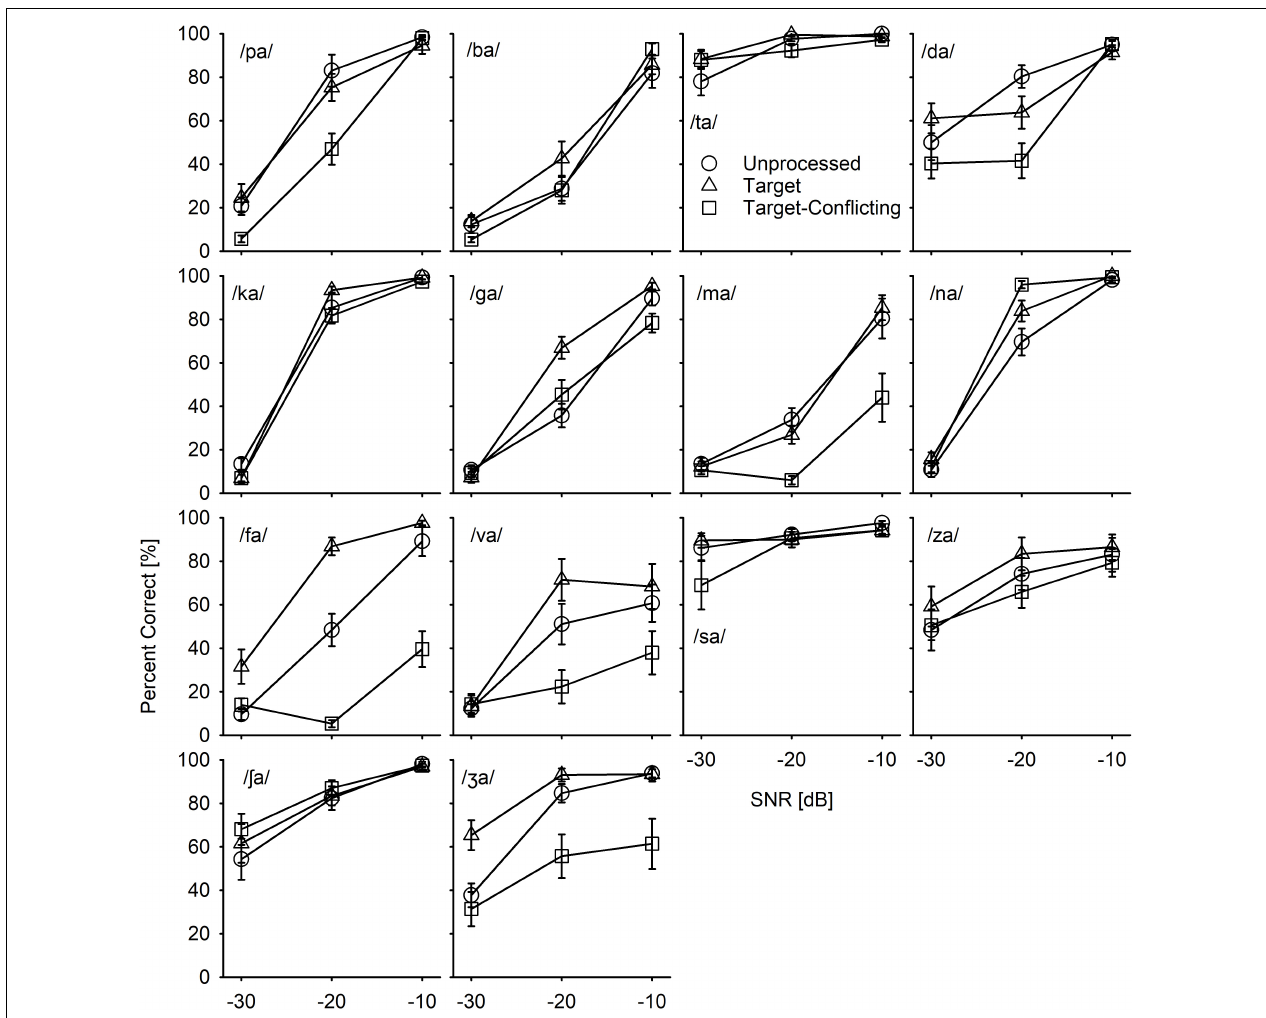
FIGURE 5 | Mean consonant recognition scores for individual consonant as a function of SNR and of the signal